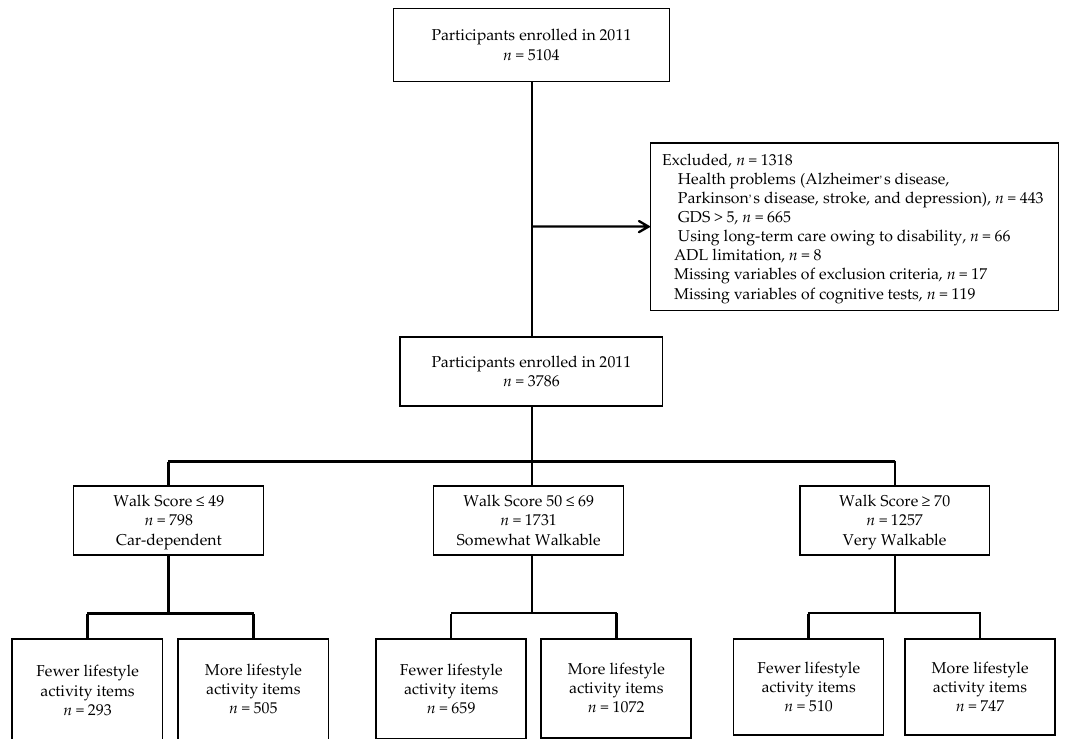
Figure 1. Flow diagram of sample selection. GDS: 15-item Geriatric Depression Scale.